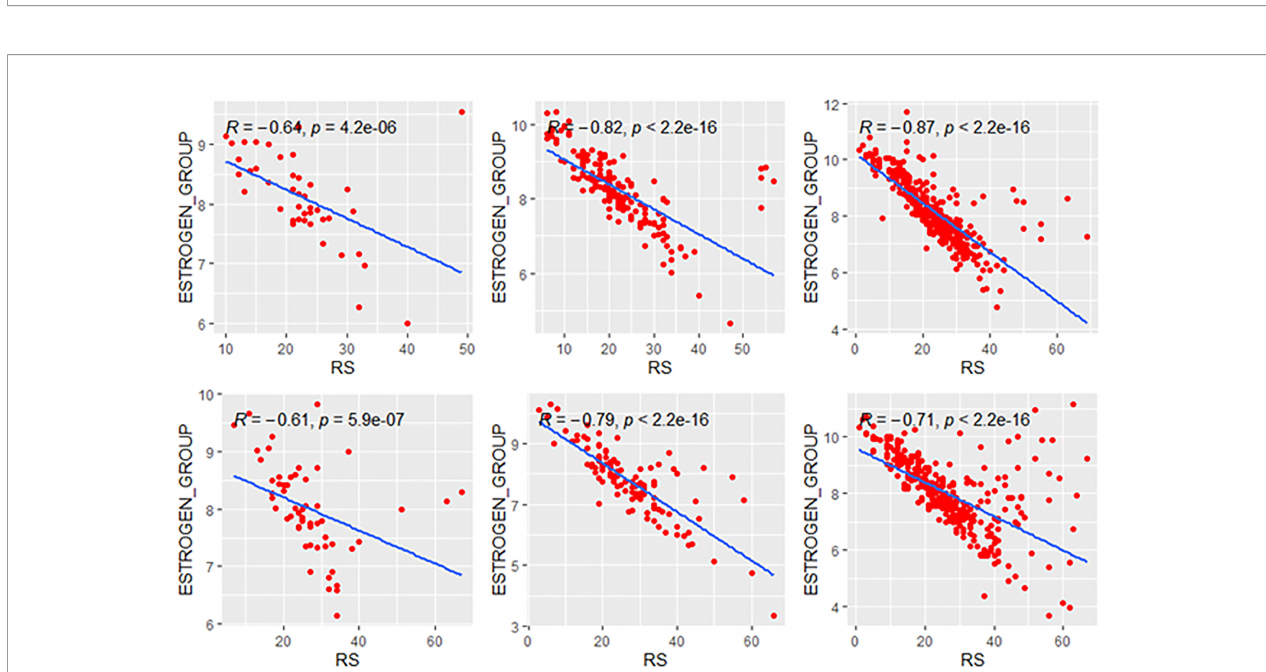
FIGURE 6 | Relationships of the RS with its estrogen module. The upside and downside ranks showed the relationship in patients with low and high clinical risk respectively. Groups A, B, and C were presented from left to right. RS, recurrence